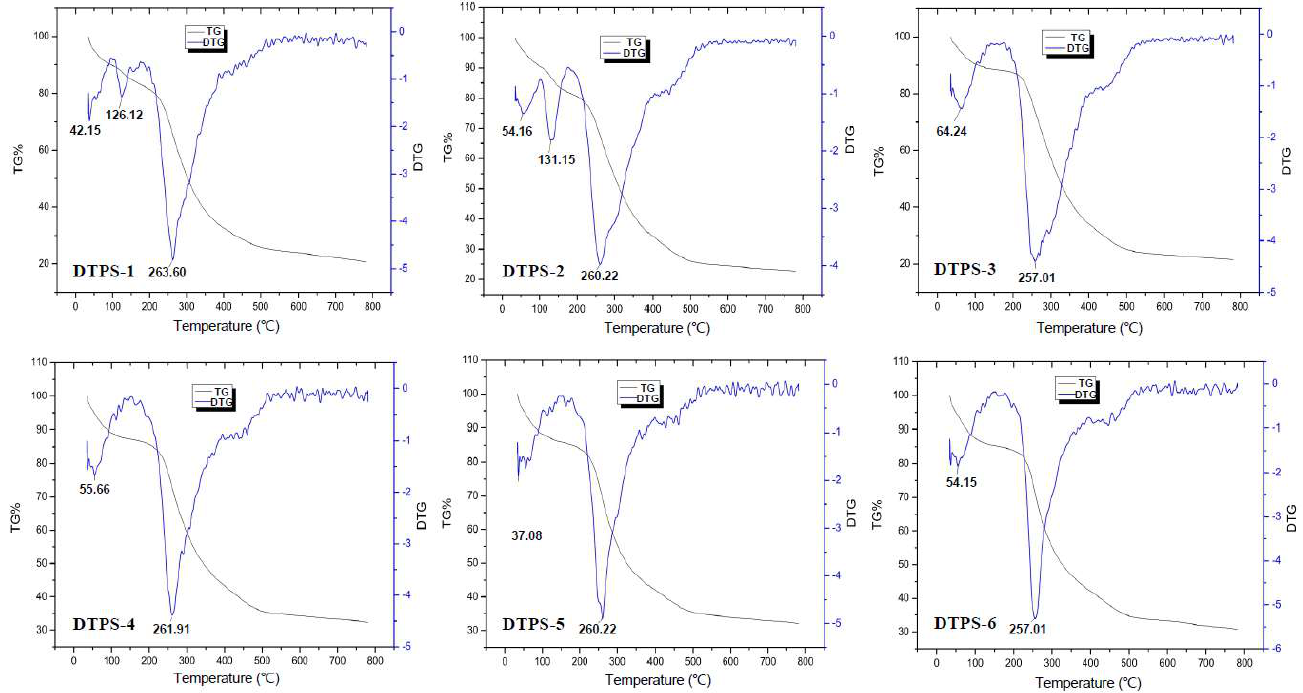
Figure 5. TG and DTG curves of the DTPSs.